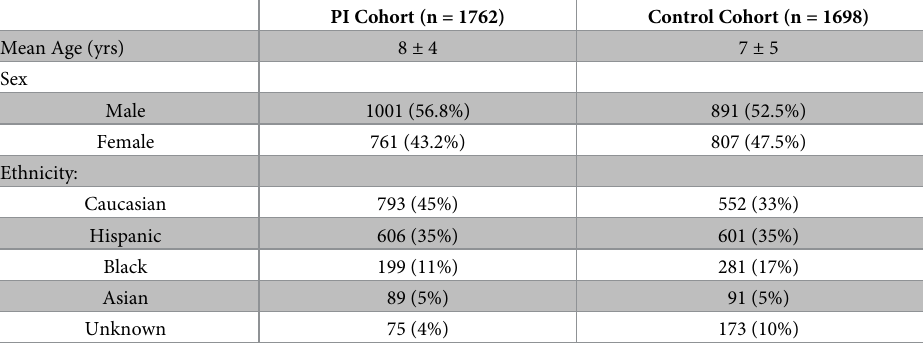
Table 1. Demographic features of the